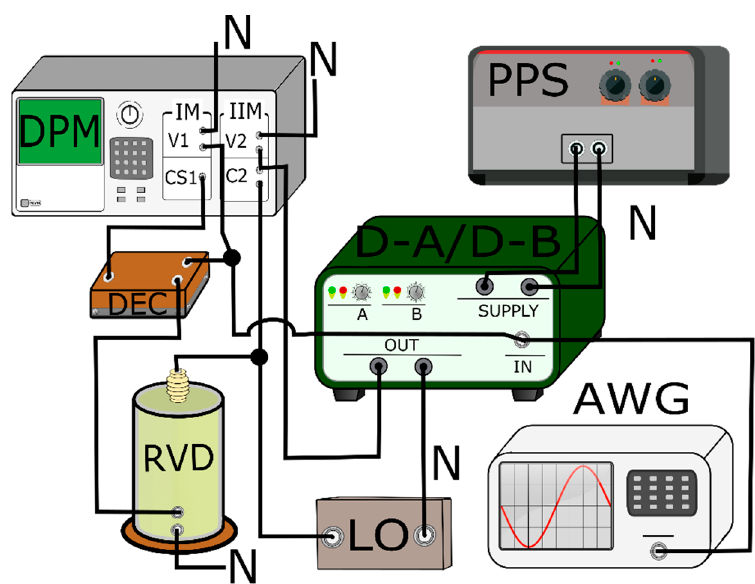
Figure 13. Measuring circuit used to determine the values of voltage gain error and phase